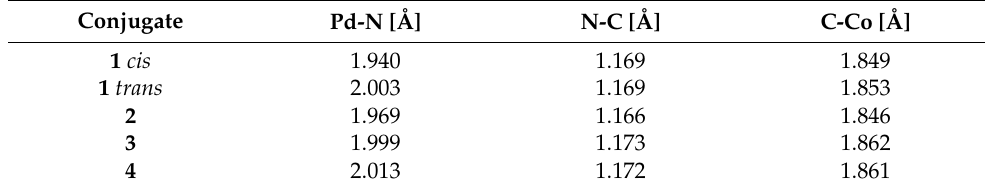
Figure 8. Geometric structures of the conjugates discussed in the current manuscript. Selected bond lengths are given in Å. Color code: C—grey, H—white, N—purple, Cl—green, Co—light blue, Pd—pink. Table 1. Selected bond lengths in the CblCN-Pd(II)